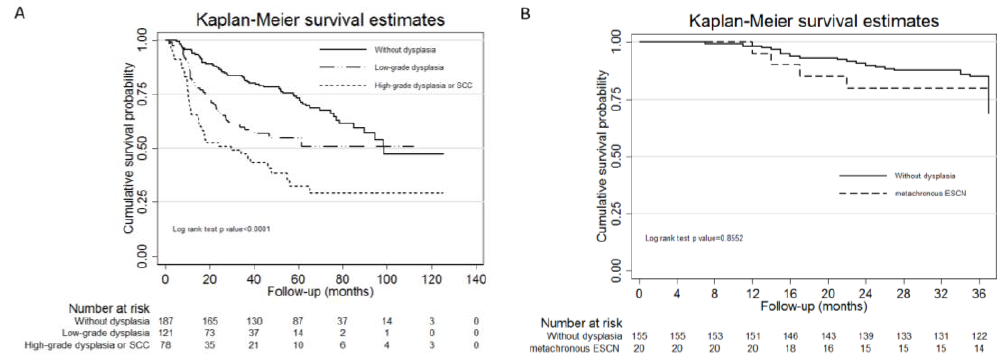
Figure 2. The Kaplan–Meier survival curves for HNSCC patients with or without second ESCNs ( A ) and HNSCC patients without dysplasia or with metachronous ESCNs ( B ). Abbreviations: HNSCC, head and neck squamous cell carcinoma; ESCN, esophageal squamous cell neoplasm.